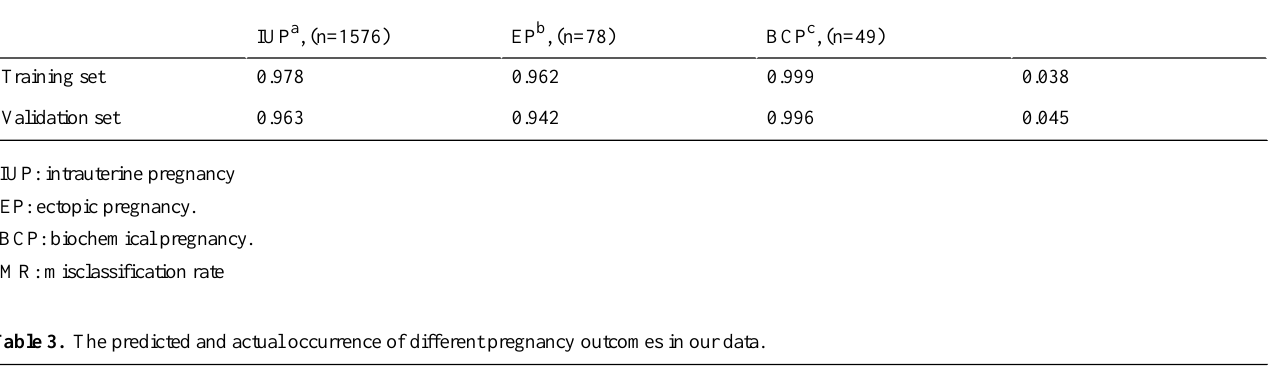
MR d Area under the receiver operating curveDatasets